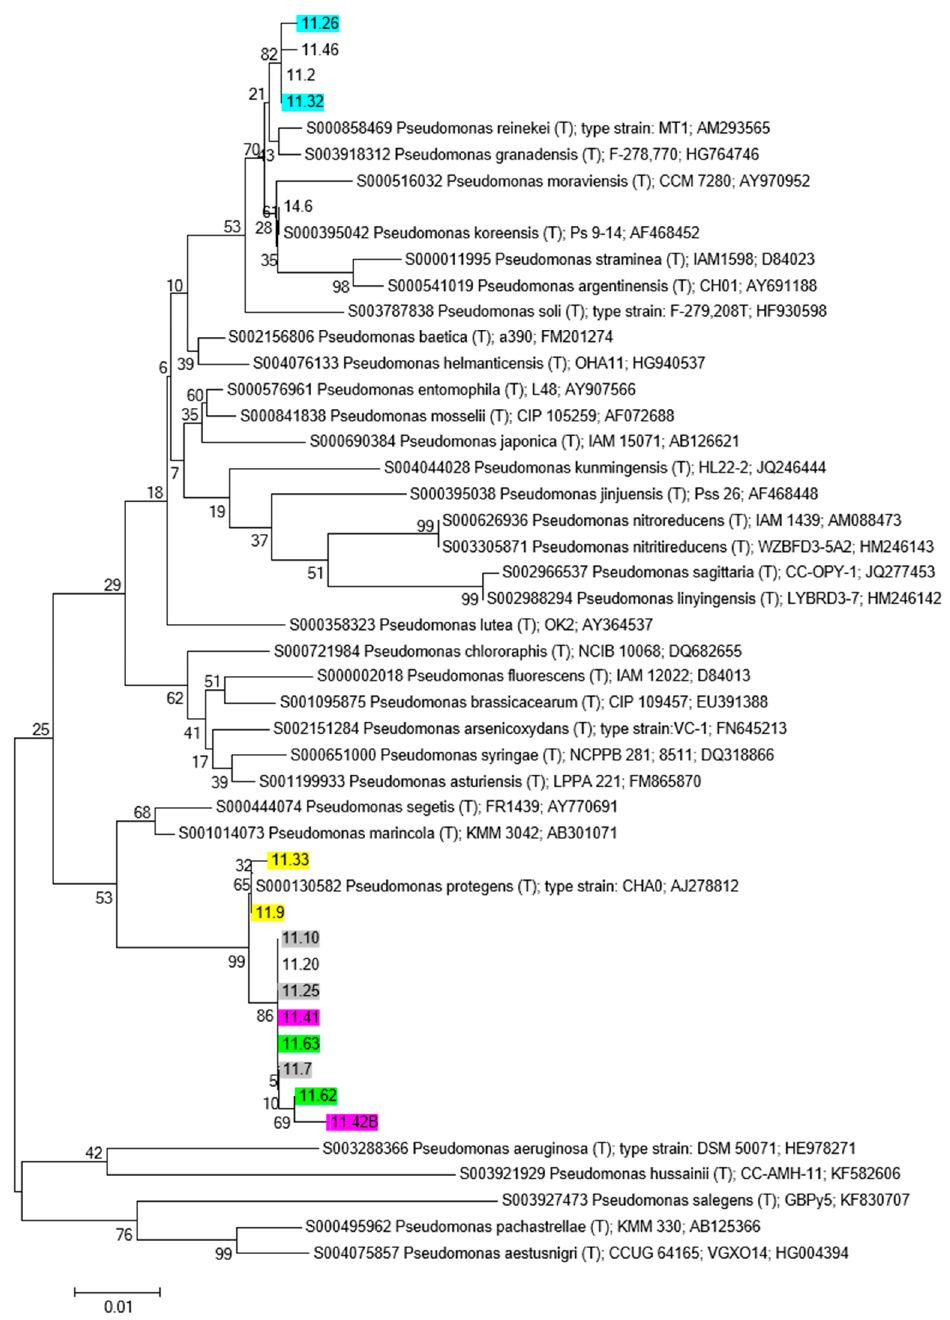
Figure 6. Phylogenetic tree showing relationships between Pseudomonas sp. isolates, and Pseudomons sp. Type Strains retrieved from RDP database. The tree was constructed based on 16S rRNA gene sequences, with Neighbor-Joining algorithm and 100 bootstrap values. Isolates exhibiting the same RAPD profile are indicated with the same color.